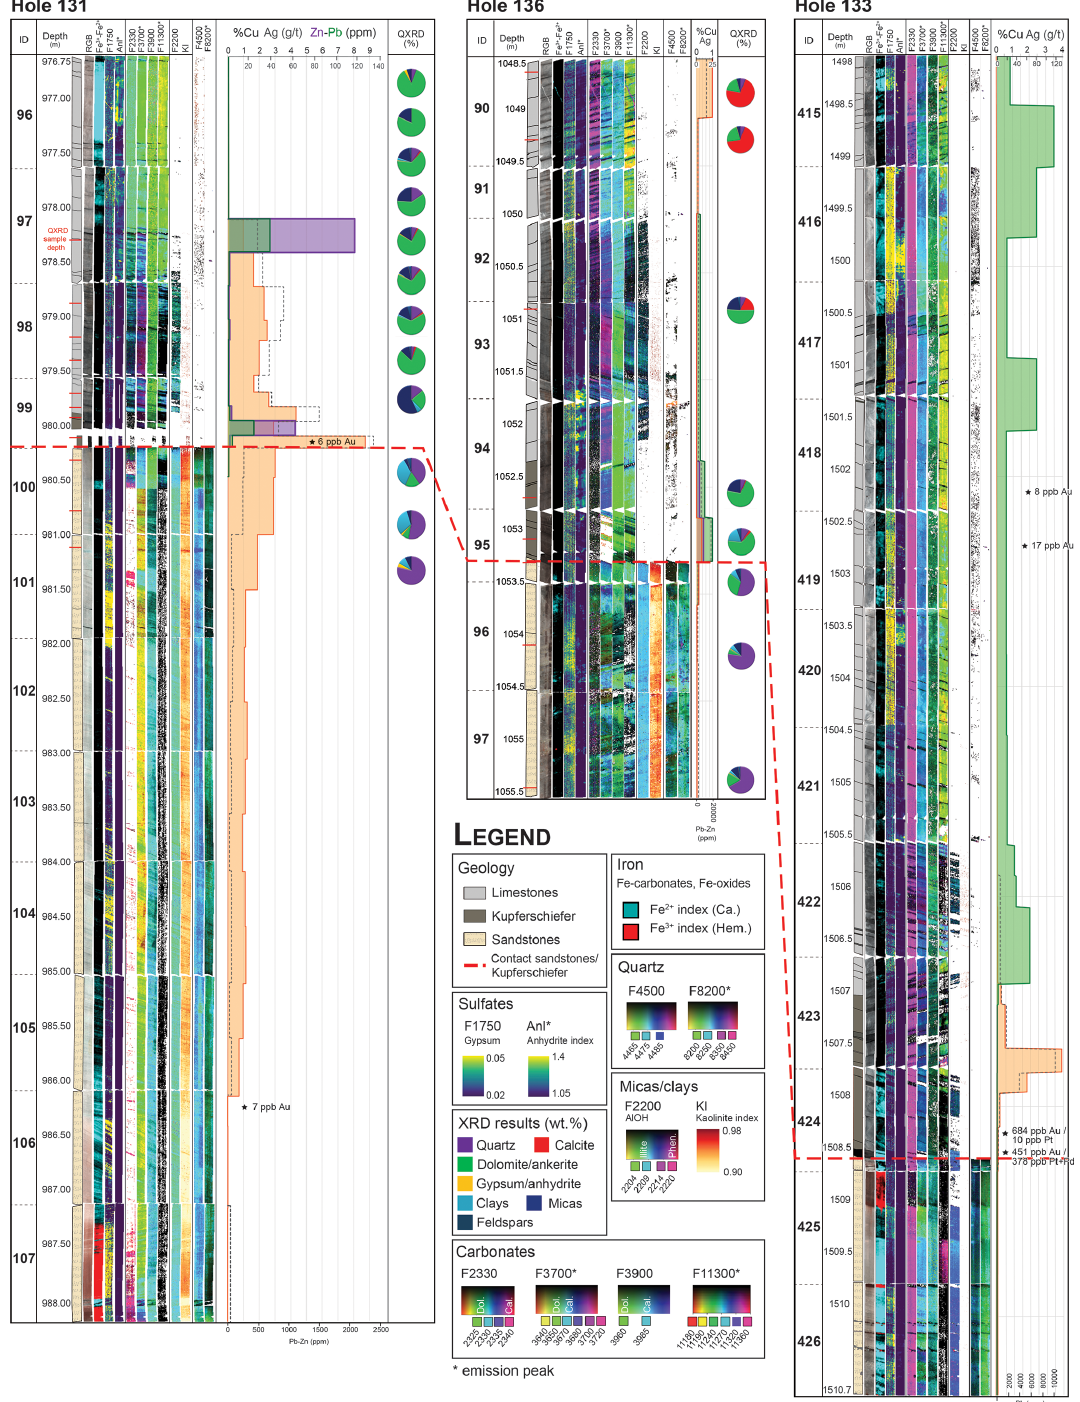
Figure A1. Spectral feature maps and copper grade of the three drill core sections.